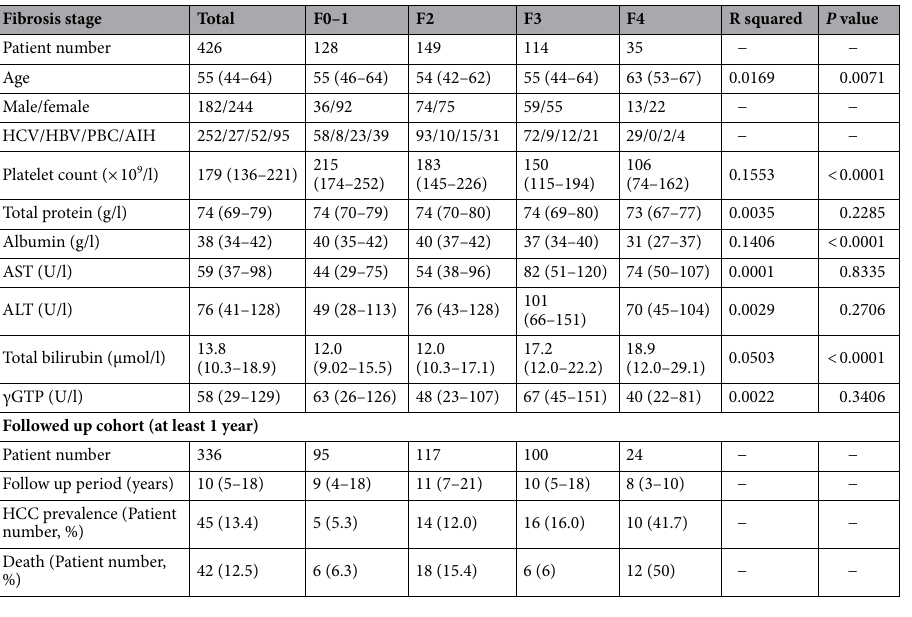
Table 1. Baseline characteristics and follow up information of a training cohort. AIH autoimmune hepatitis, HBV hepatitis B virus, HCC Hepatocellular carcinoma, HCV hepatitis C virus, PBC primary biliary